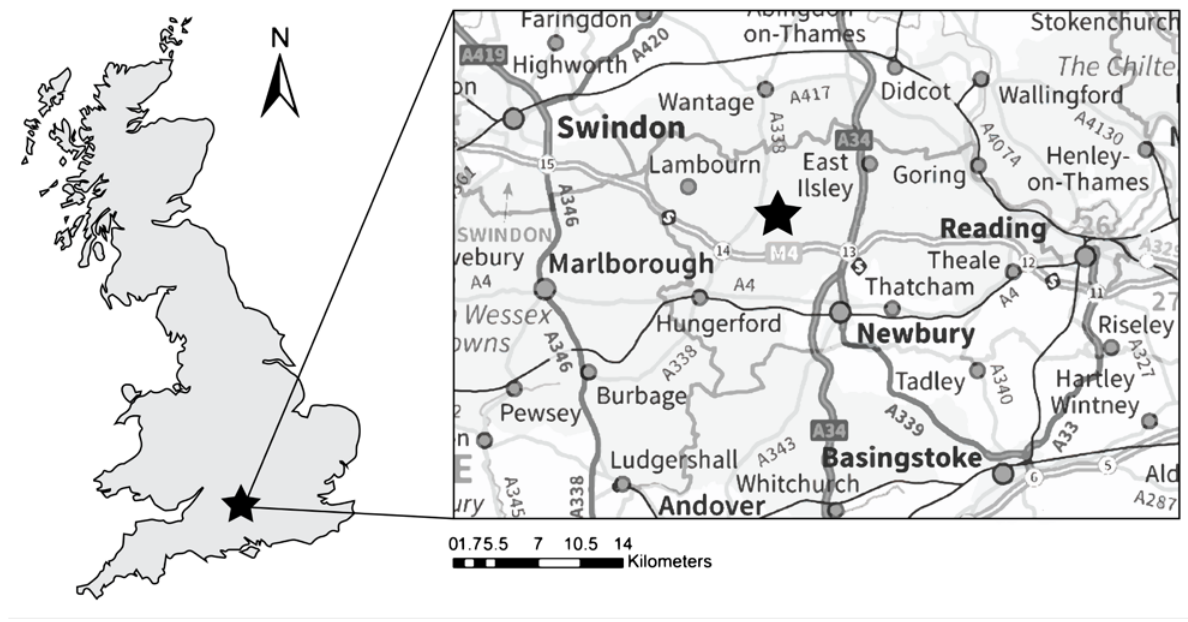
Figure 1. Study site location on the River Lambourn, southern England, UK. © Environment Agency 2021. All rights reserved. © Crown copyright and database rights 2021 Ordnance Survey 100024198.